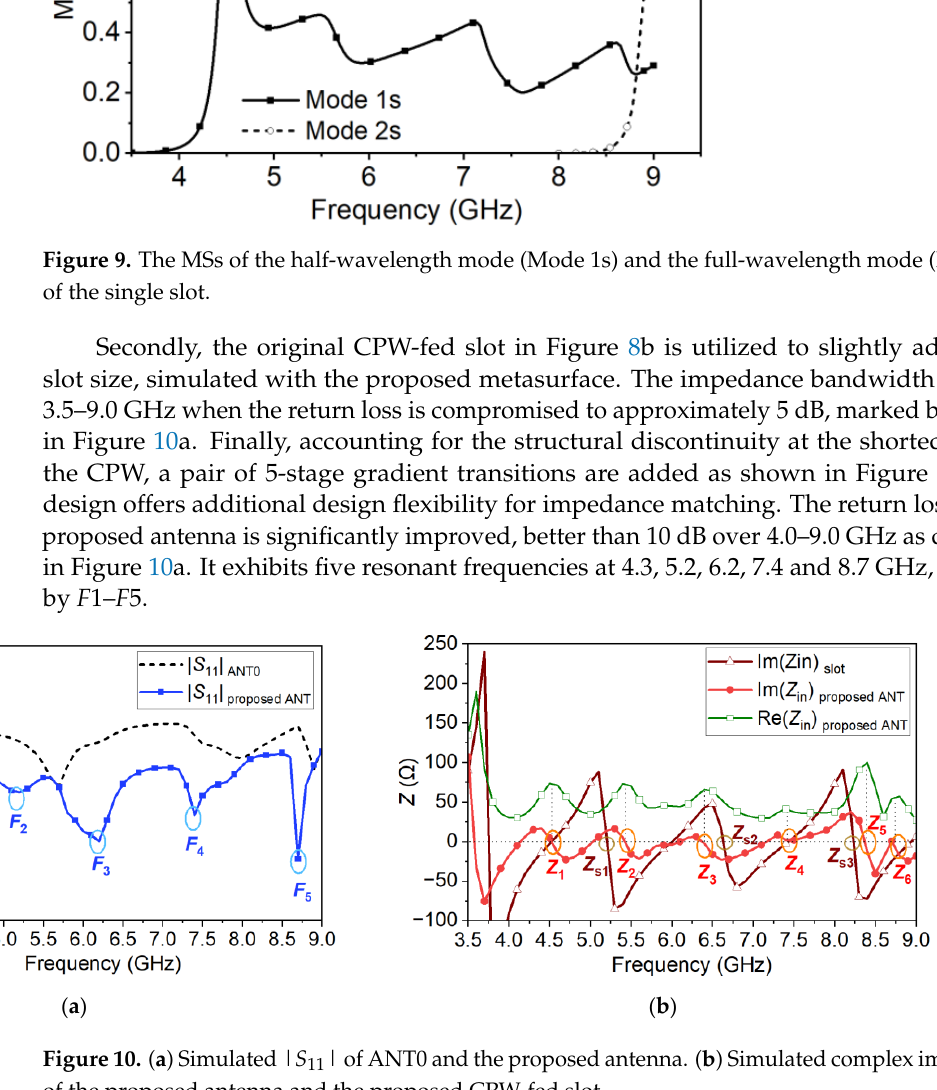
Figure 10. ( a ) Simulated | S 11 | of ANT0 and the proposed antenna. ( b ) Simulated complex imped- ance of the proposed antenna and the proposed CPW-fed slot.